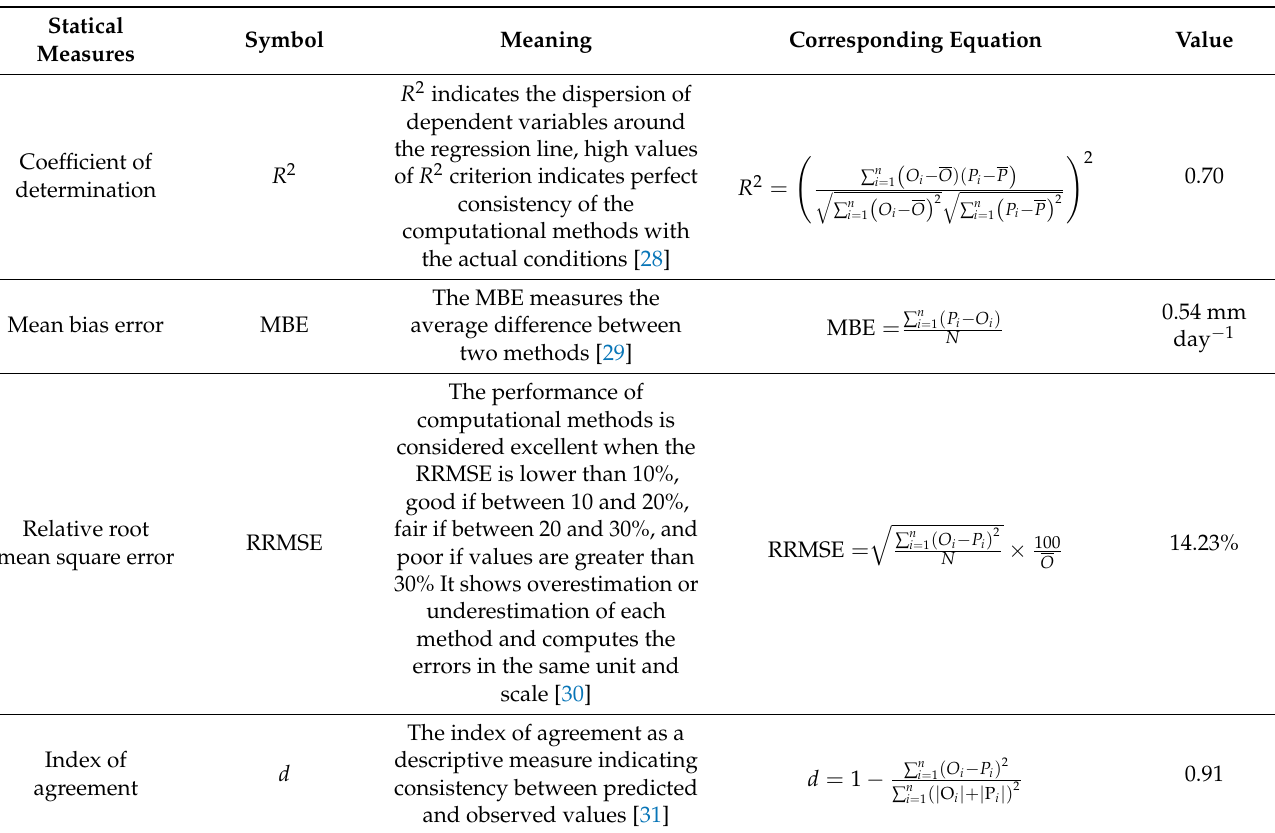
Table 1. Statistical measures calculated for ET estimation equations between the common method and IO